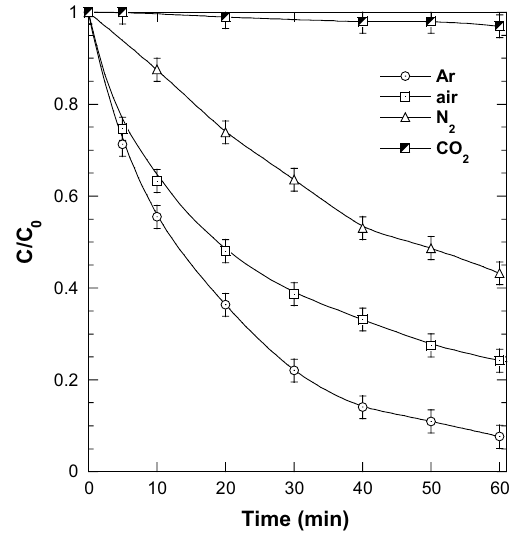
Fig. 9 Degradation kinetics of TB for various saturating gases (condi- tions—volume: 100 mL, initial TB concentration: 2 mg L −1 , tempera- ture: 25 ± 2 °C, pH ~ 6, frequency: 1700 kHz, power: 15